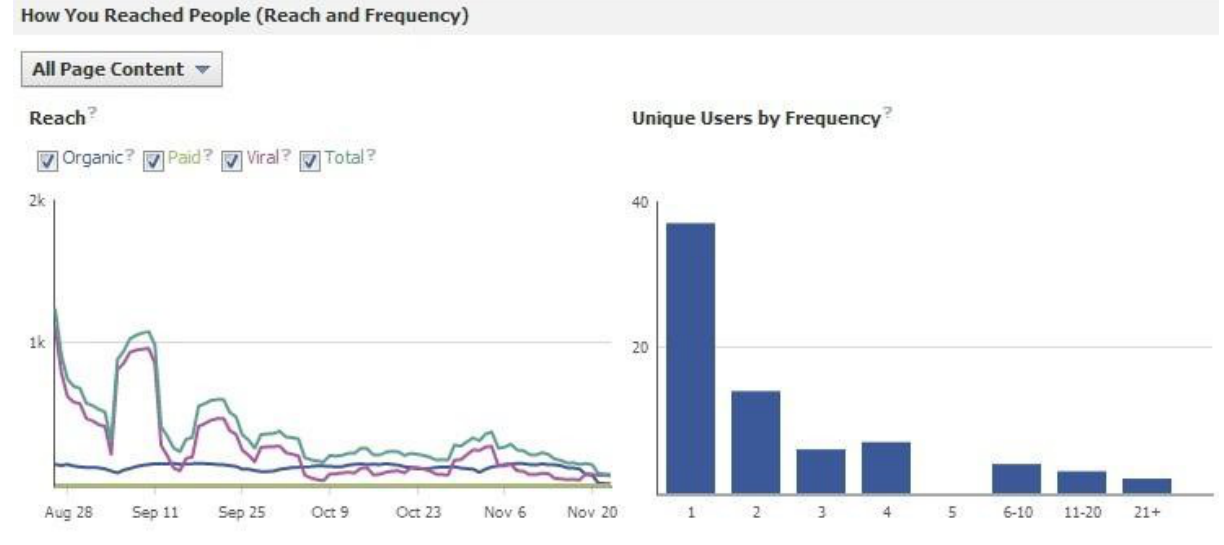
Figure 7. Frequency and quantity of reach per unique views for the Corporate Facebook page, generated in Facebook